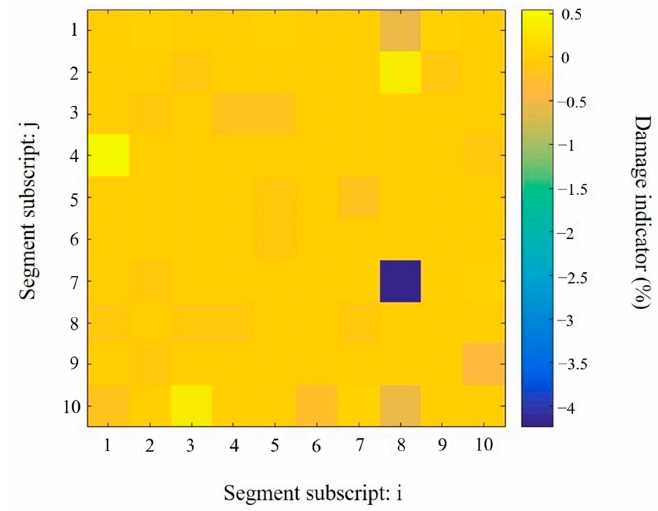
Figure 11. Damage identification results in the plate obtained using the proposed approach with sparse regularization.